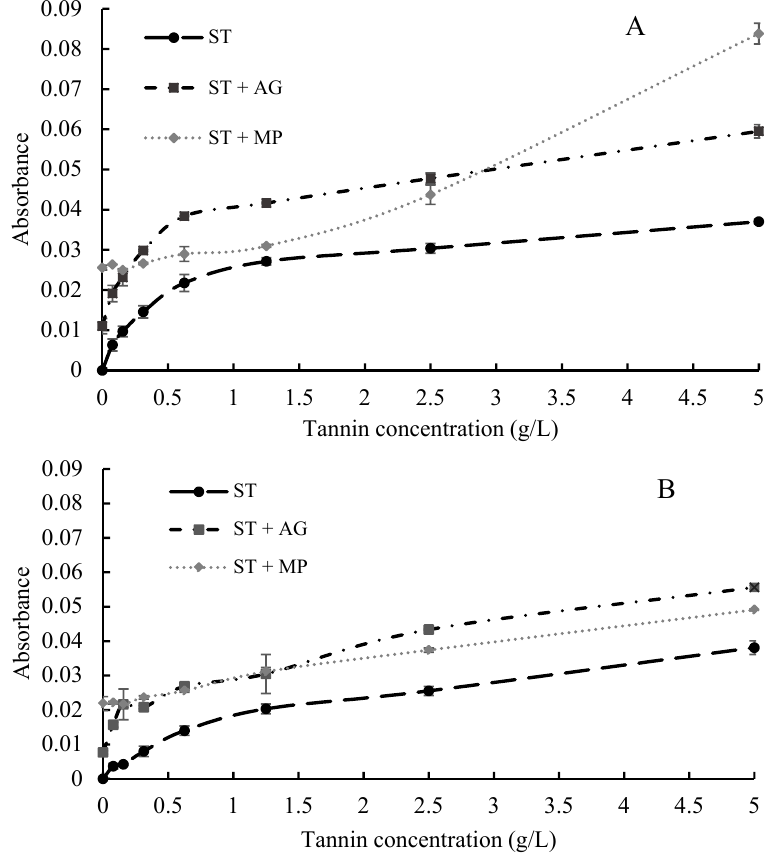
Figure 2. Absorbance (650 nm) of seed tannin from 0 to 5 mg / mL, with or without addition of polysaccharides in ( A ) 12% ethanol model wine and ( B ) 15% ethanol model wine.